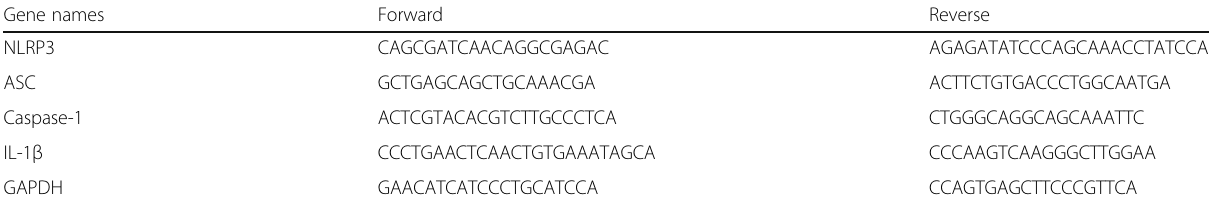
Table 1 Real-time fluorescent quantitative PCR